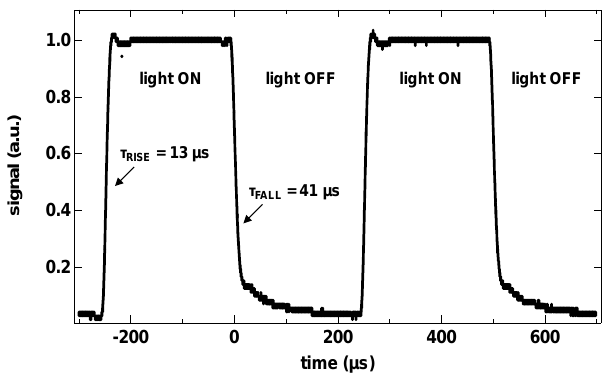
Figure 13. Transient characteristics of a test QDPD device with an active area of 0.041 cm 2 and under illumination with a switching NIR LED.